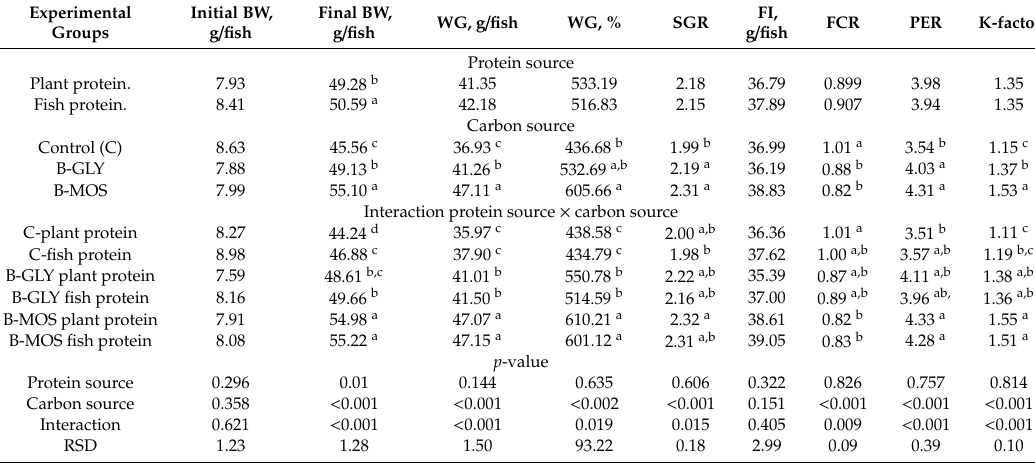
Table 4. The e ff ect of di ff erent dietary protein sources and carbon sources on Nile tilapia ( O. niloticus) growth